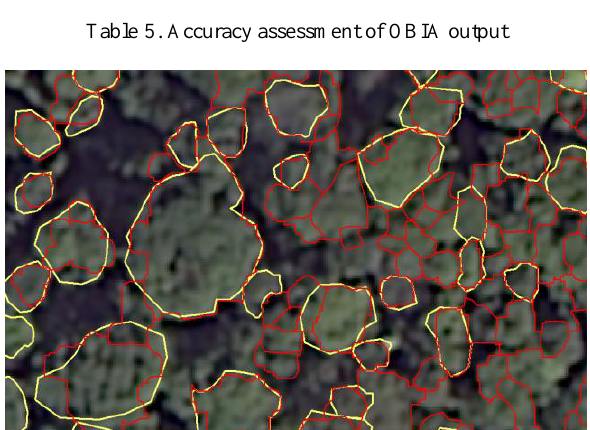
Figure 7. The segmented (Red colour) and Reference (Yellow)